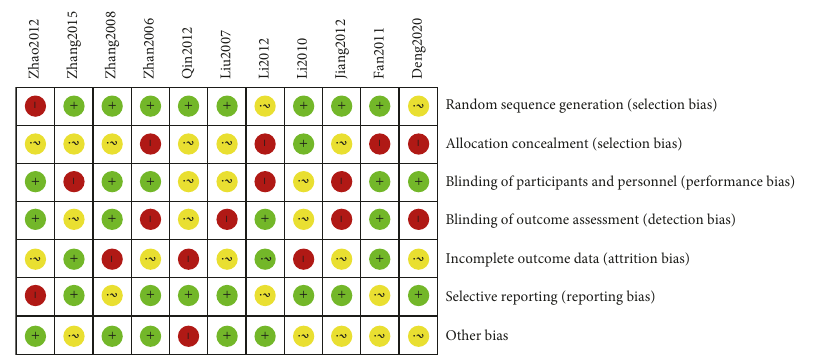
Figure 2: Risk of bias summary.